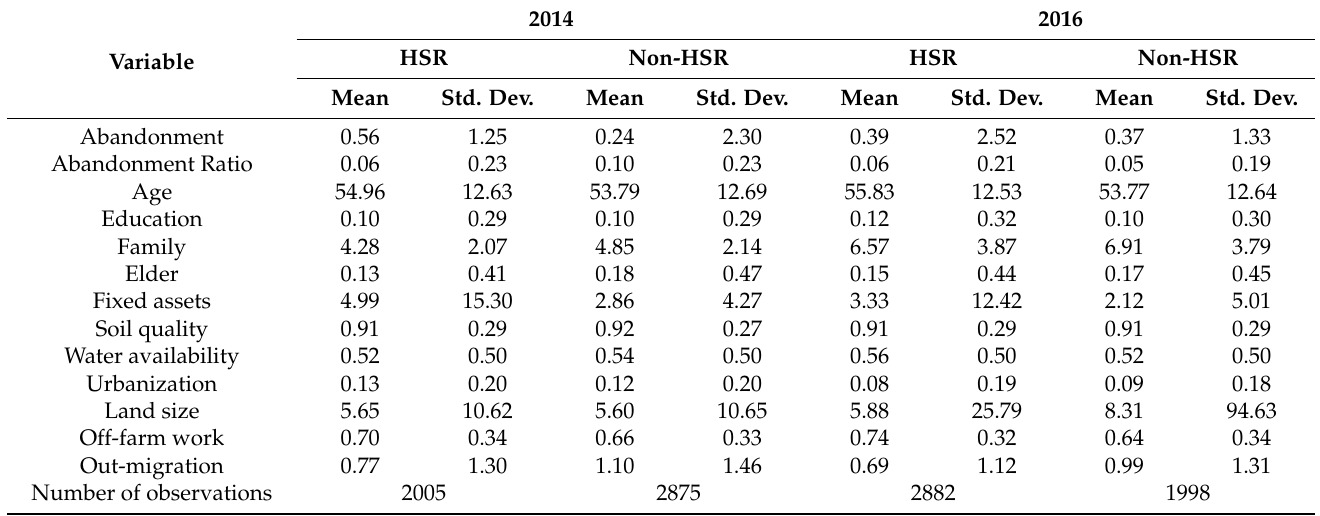
Table 2. Summary statistics for the crucial